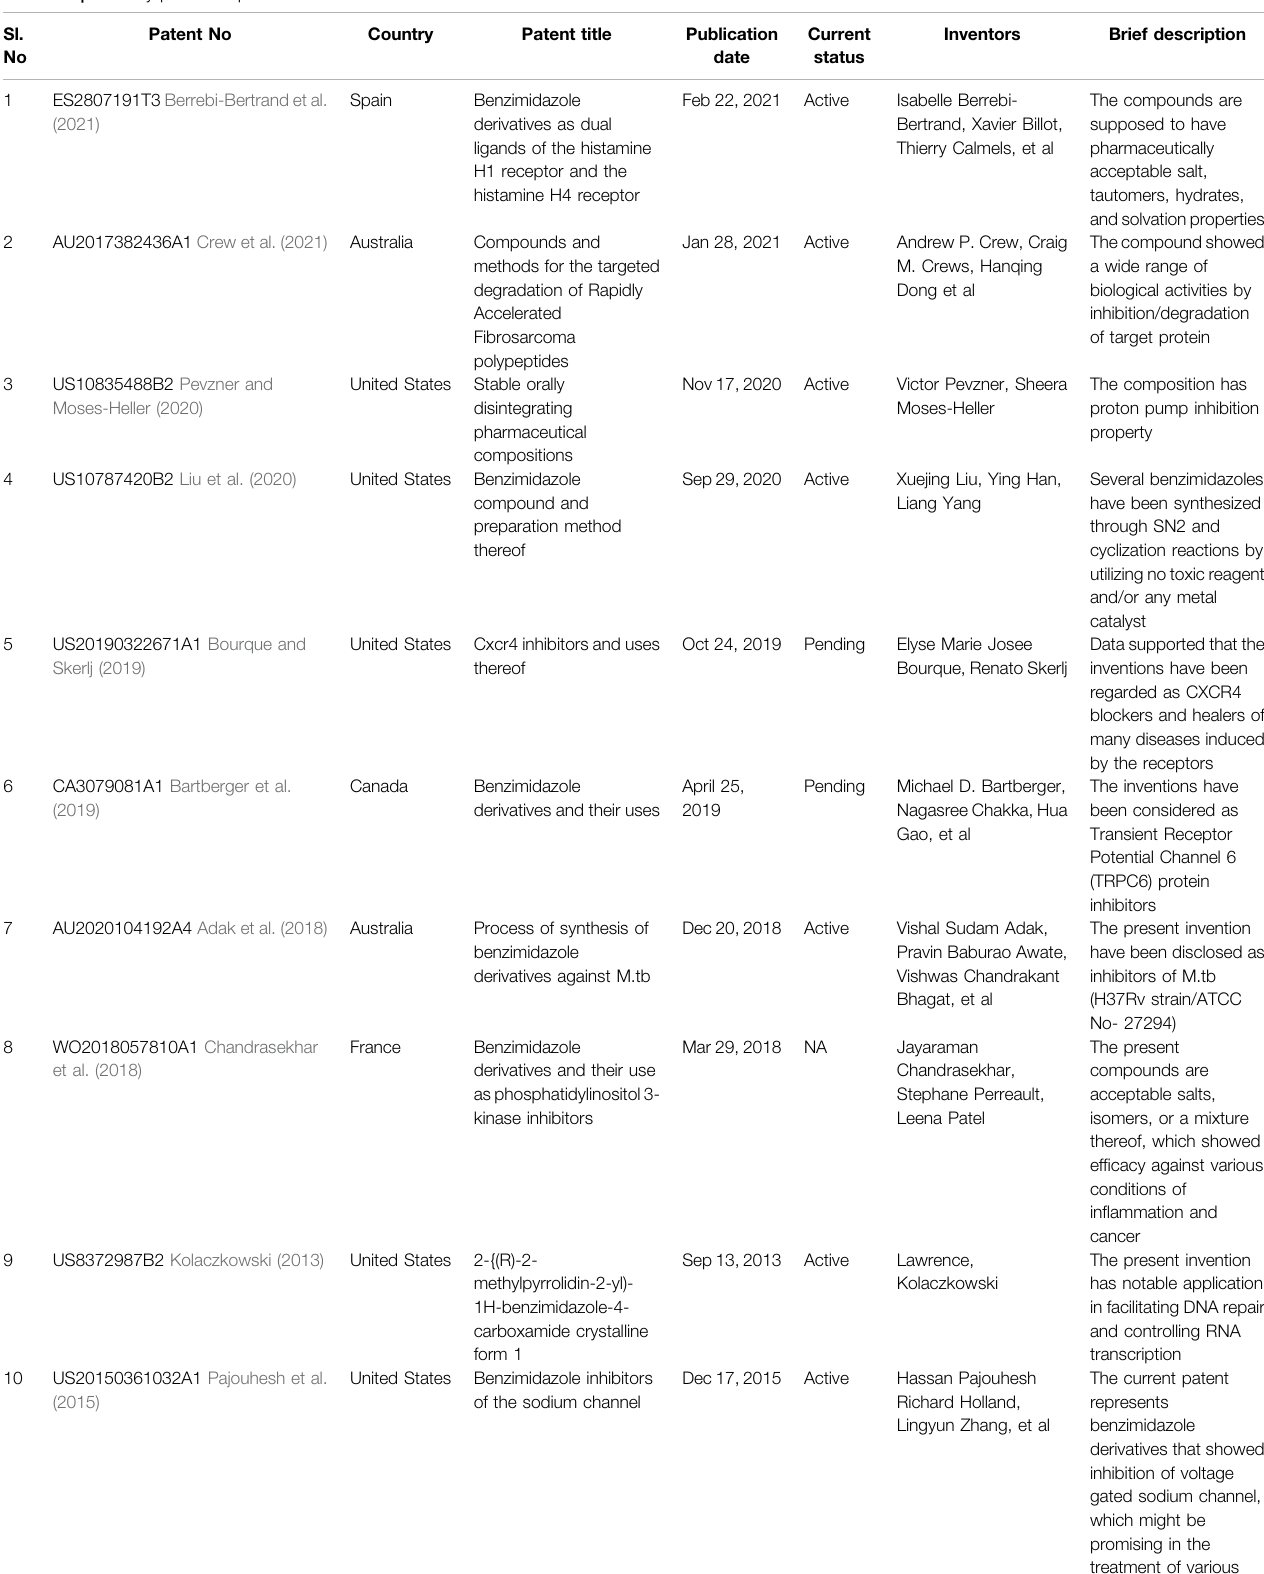
TABLE 1 | Recently published patents of benzimidazole